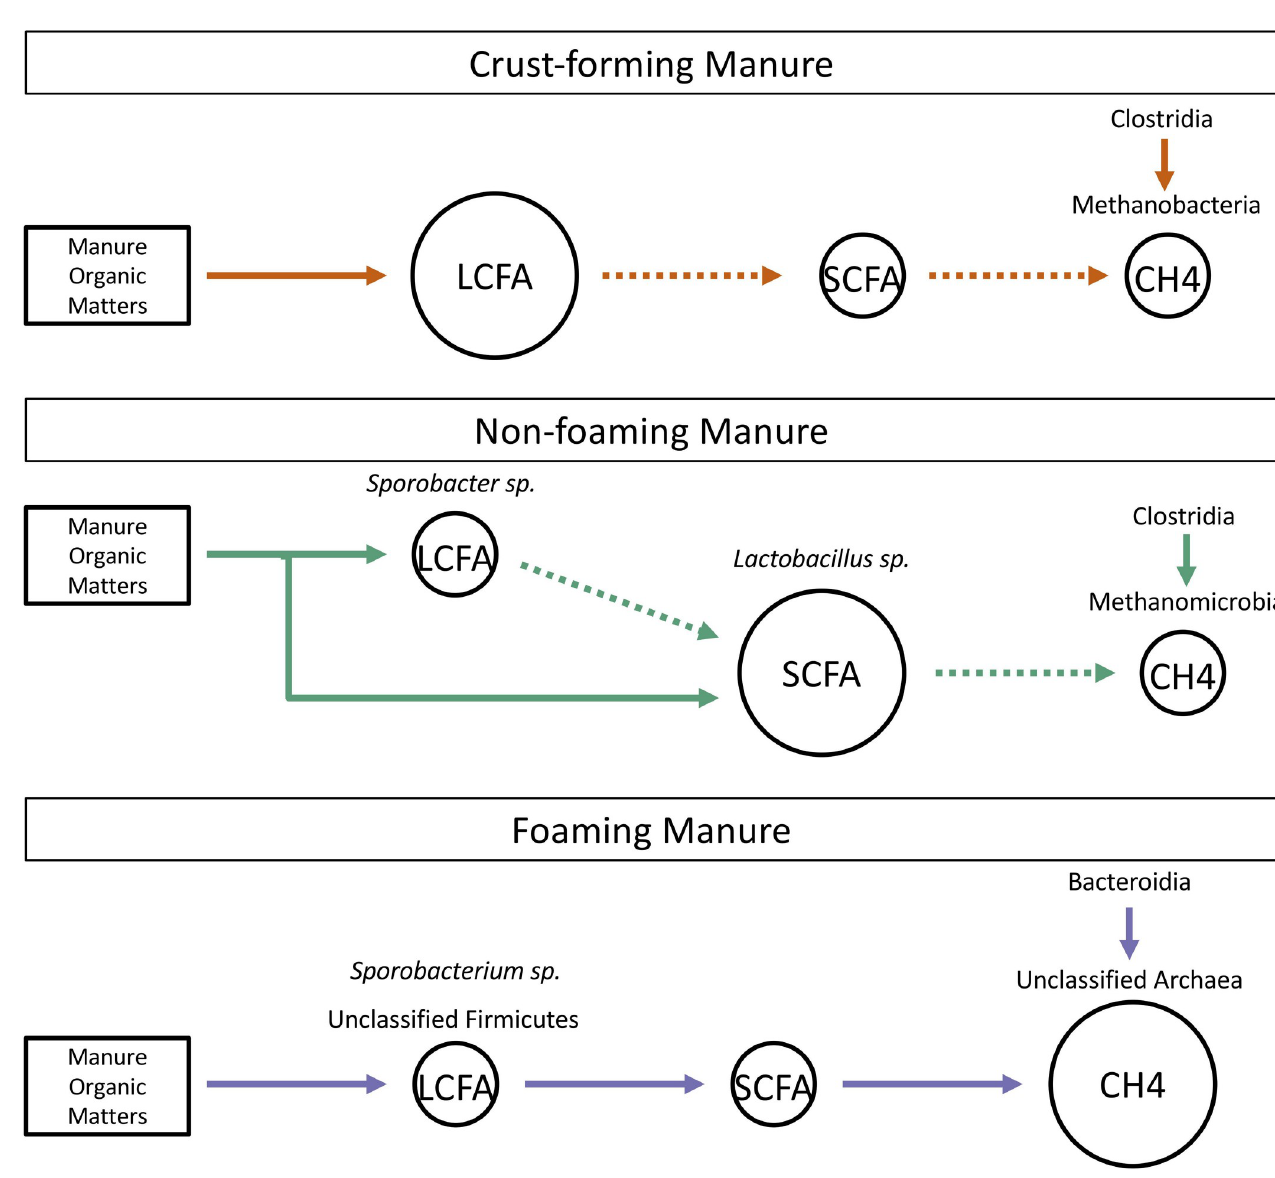
Fig 7. The predicted manure fermentation processes in crust-forming, non-foaming, and foaming manure. The solid and dashed lines represent efficient and inefficient processes, respectively. The circles represent the fermentation by-product and the large circle indicates the accumulation of the by-product. The microorganisms that strongly and positively correlated with the by-product are listed above the